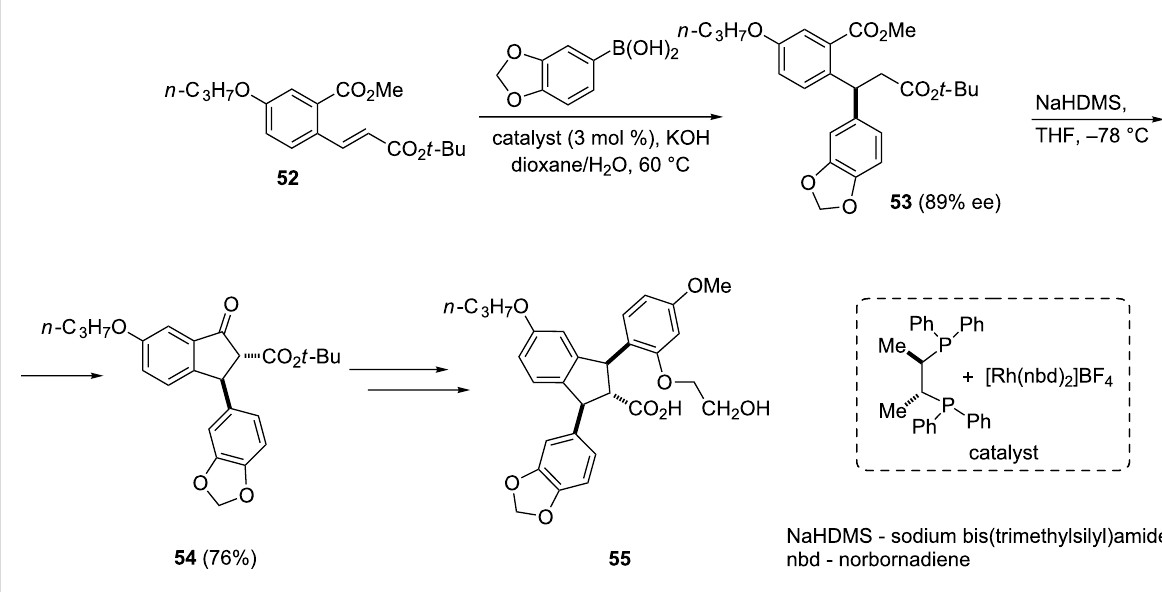
Scheme 19: Synthesis of the selective endothelin A receptor antagonist 55 .